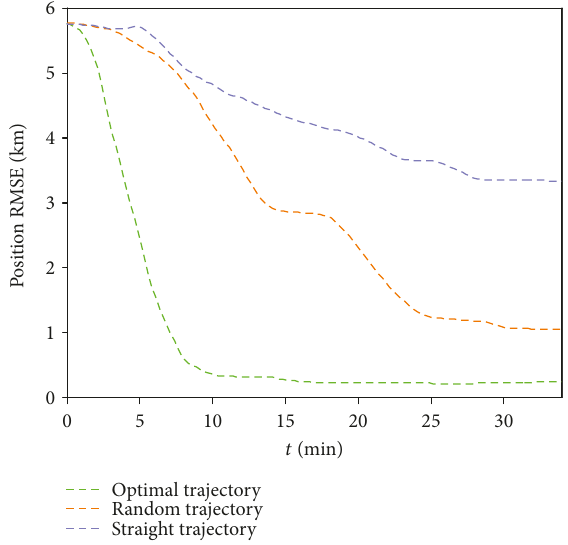
Figure 14: Comparison of position RMSE with di ff erent